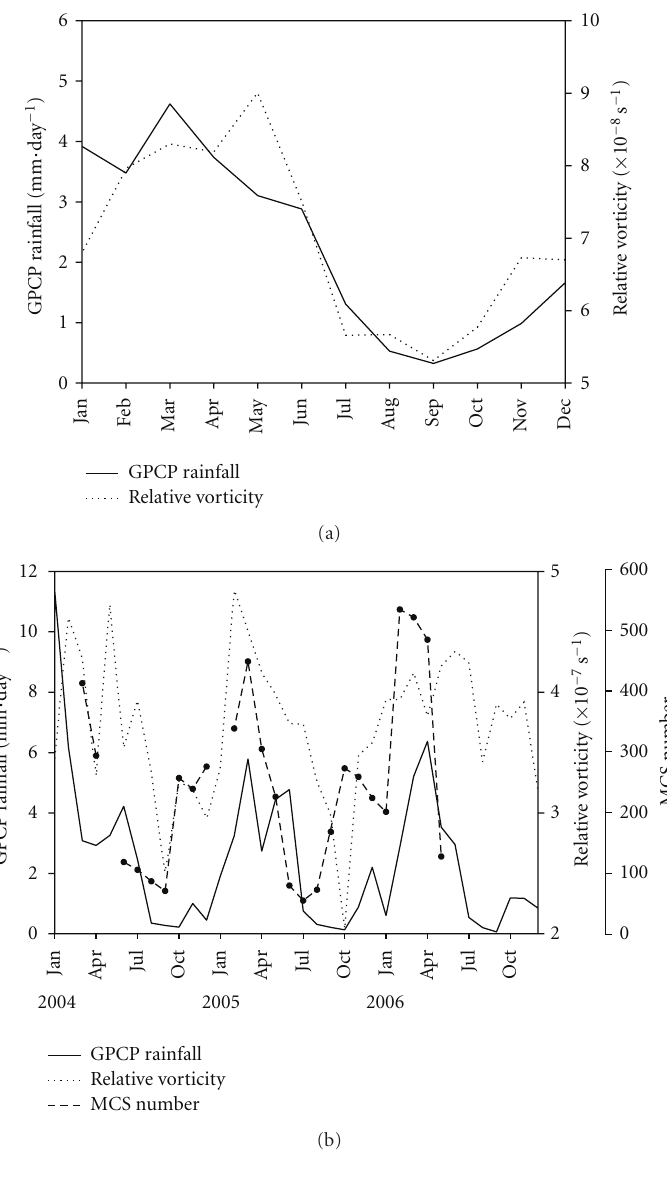
Figure 3: (a) Monthly climatology averaged for the period 1997–2006 of GPCP rainfall (solid line, mm · day − 1 ) calculated over ENEB and 700hPa positive vorticity (light dashed line, 10 − 8 · s − 1 ) inside the area 2.5 ◦ S–12.5 ◦ S, 40 ◦ W–20 ◦ E. (b) Same as (a) during the three years 2004–2006; Monthly number of MCSs (lifespan > 2 hours) that moved westward (dashed-dotted line) from 20 ◦ W up to ENEB and had a dissipation coordinate ranging between 2.5 ◦ S and 12.5 ◦